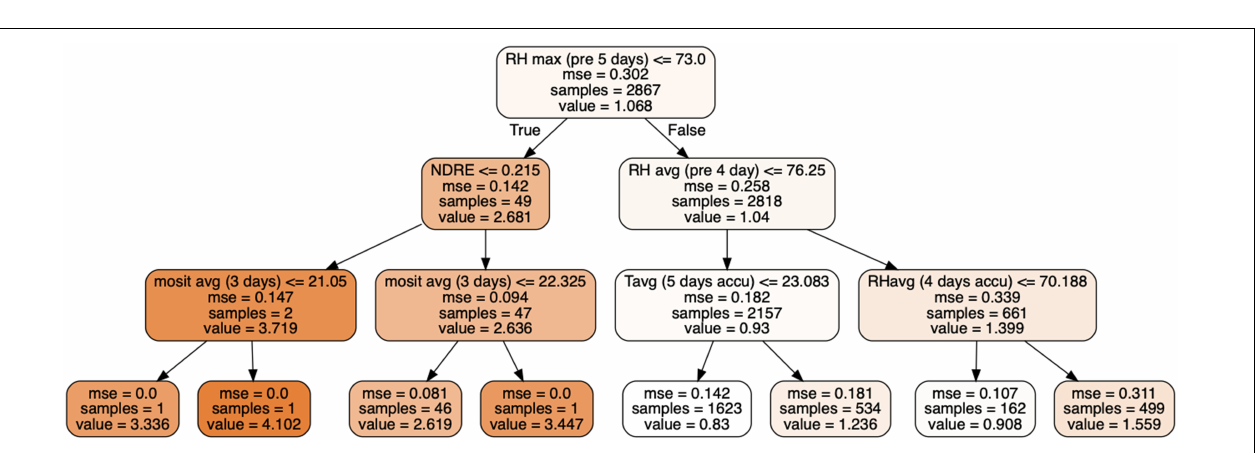
FIGURE 3 | Top important variables for the (A) complete RF model; (B) simplified RF model with N rates, traffic intensities, and weather inputs; (C) weather-only RF model with all the weather variable inputs.